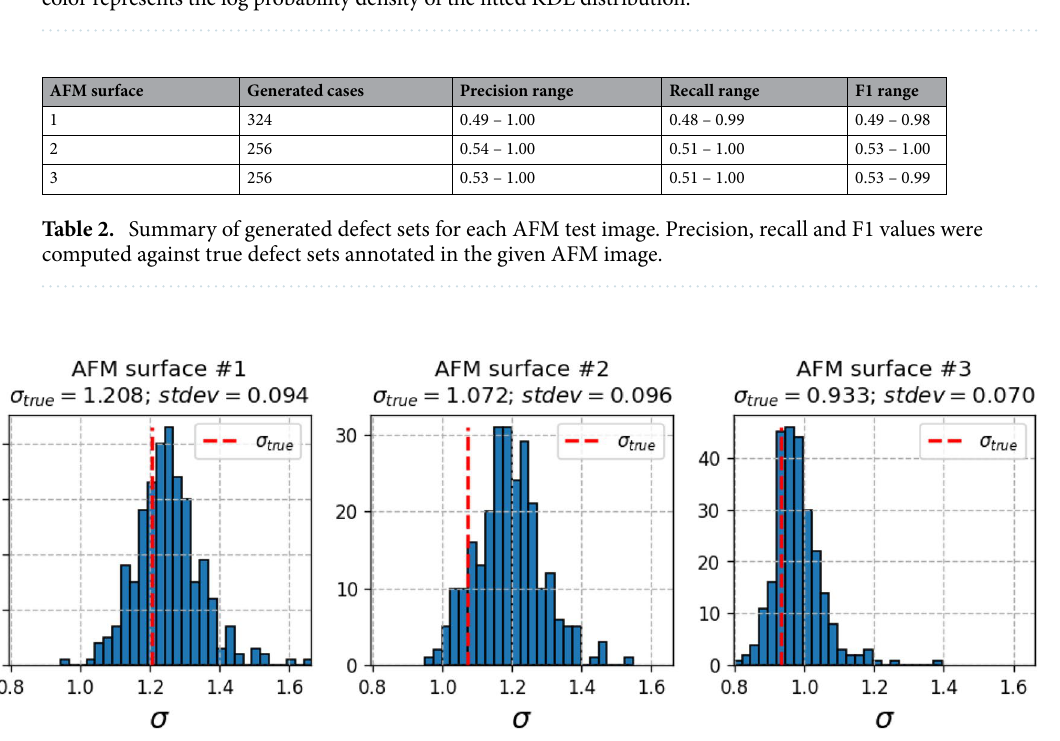
Figure 3. KDE model of true defect coordinates (white dots) annotated for AFM test image #1. Background color represents the log probability density of the fitted KDE distribution.